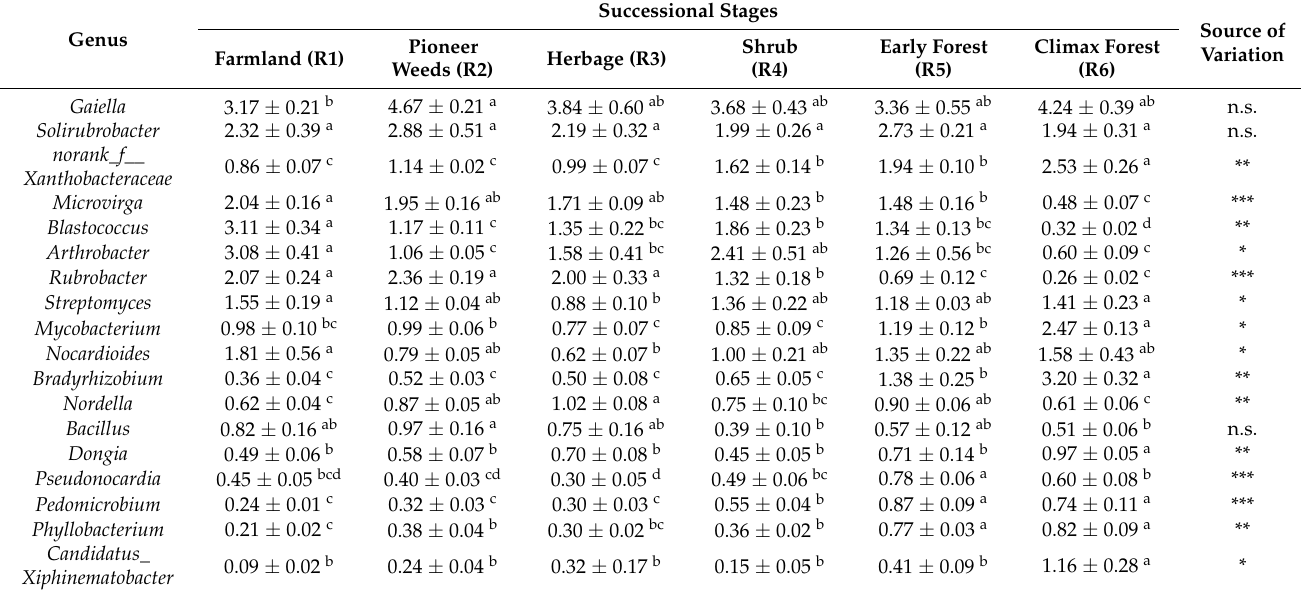
Table 3. Relative abundance (% of individual taxonomic groups) of the dominant bacterial genera (mean ± SE, n = 4) present in the soil (0–20 cm depth) microbial communities of different successional stages on the Loess Plateau of